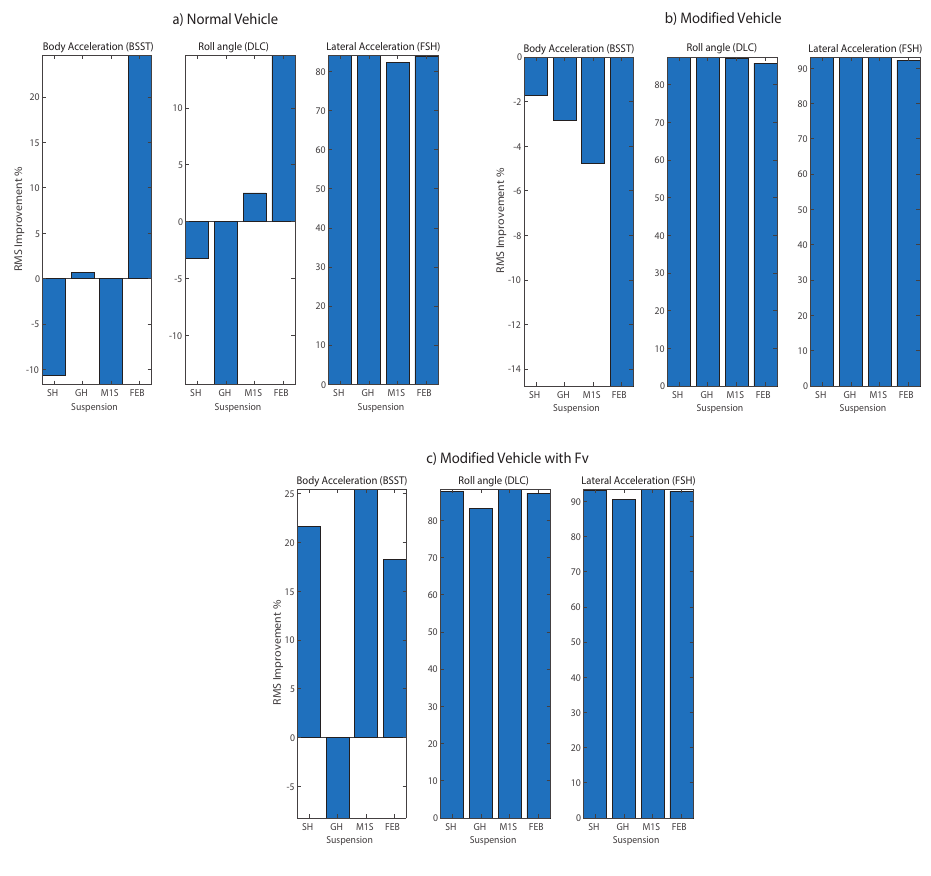
Figure 20. Full vehicle